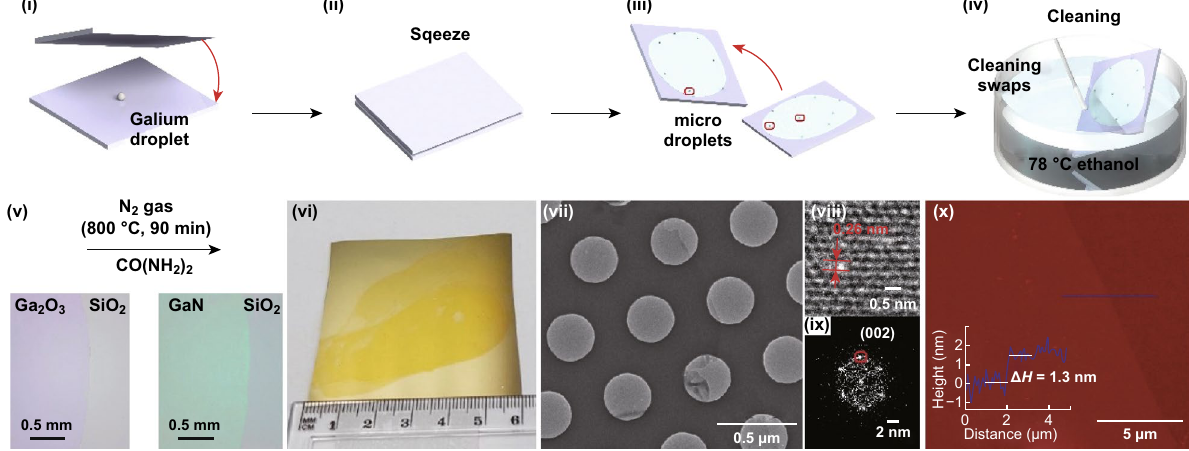
Fig. 11 Large-area synthesis of 2D GaN. ( i – v) Schematic illustration of the synthesis and cleaning process of 2D Ga 2 O 3 on 300 nm SiO 2 /Si, then transferring them to the 2D GaN nanosheet from using ammonolysis. ( vi ) Optical image of LM synthesised Ga 2 O 3 on SiO 2 /Si wafer in centimetre scale. ( vii ) TEM micrograph, ( viii ) HRTM lattice fringes, ( ix ) the corresponding FFT pattern, and ( x ) Typical AFM topography with height profile along the blue line of the GaN film. Adapted with permission from Ref. [51]. Copyright 2019, American Chemical Society Pub- lishing Group. (Color figure